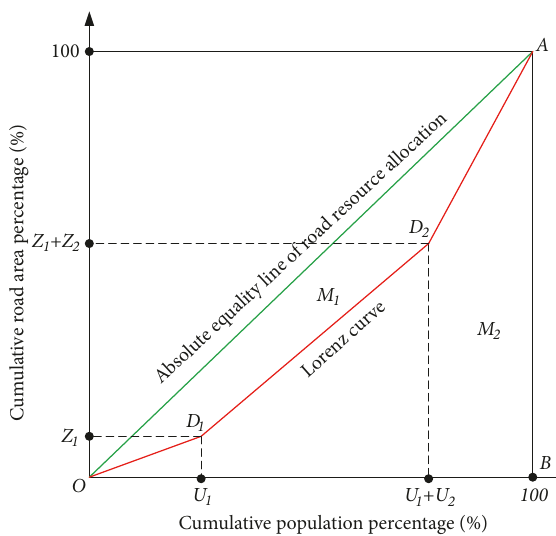
Figure 3: Lorenz curve for transport resource